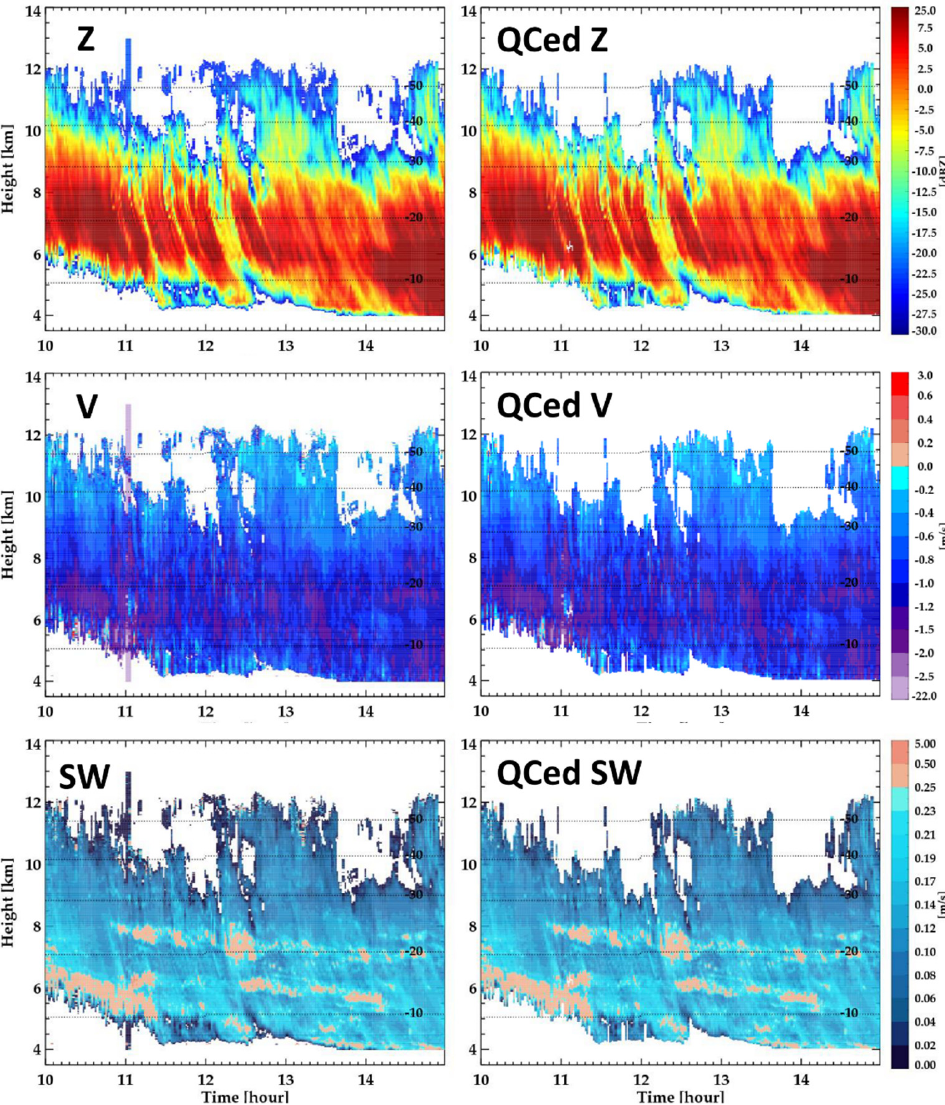
Figure 2. Time–height cross-sections of Z , V D , and SW of (left) before and (right) after applying quality control for a case of anvil on 22 May 2015. Dotted line is temperature from sounding data.